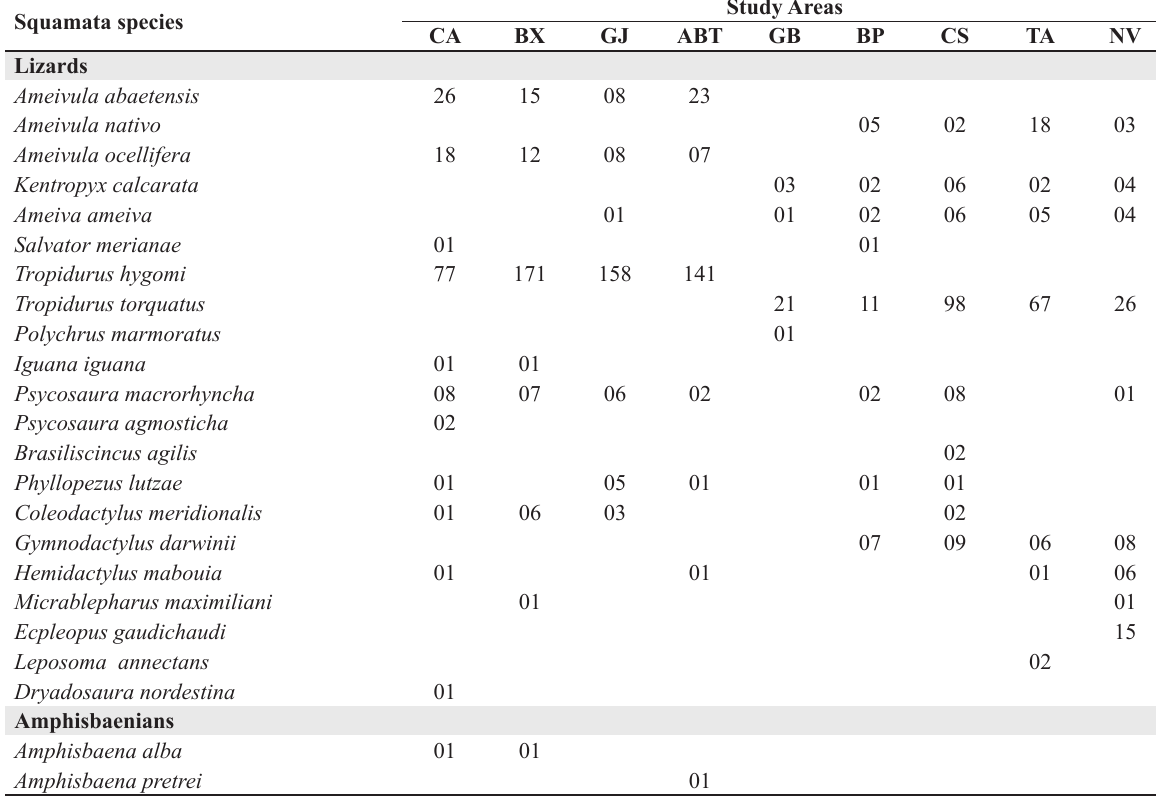
Composition and abundance of 36 Squamata species from nine restinga ecosystems studied along the coast of the State of Bahia, northeast Brazil. Study areas abbreviations: CA = Costa Azul; BX= Baixio; GJ=